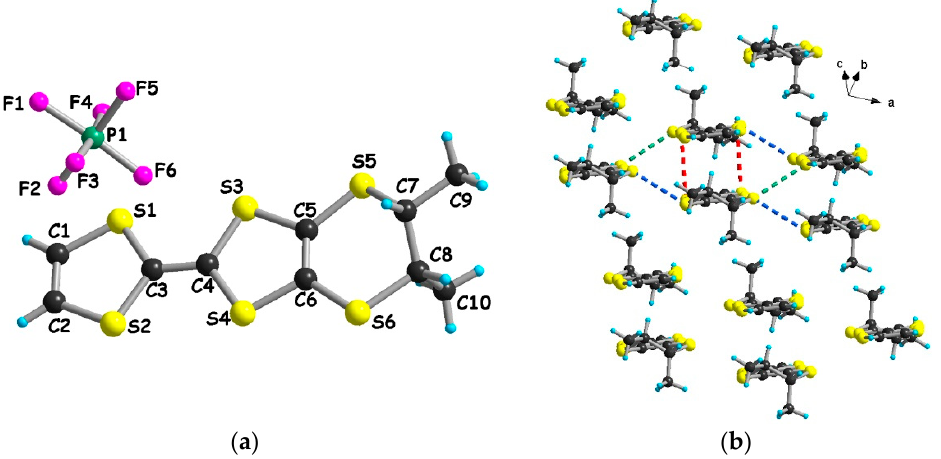
Figure 11. ( a ) Molecular structure of [( meso )- 2 ]PF 6 ; ( b ) Packing diagram for [( meso )- 2 ]PF 6 with S ··· S short contacts highlighted. Red dotted lines (3.35–3.37 Å), blue dotted lines (3.75–3.81 Å), green dotted lines (3.64–3.68 Å). The anions are not